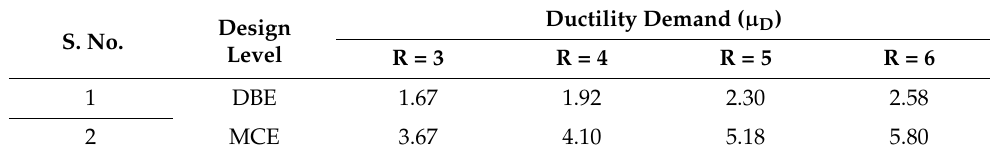
Table 7. Ductility demand at each building case under bidirectional loading.